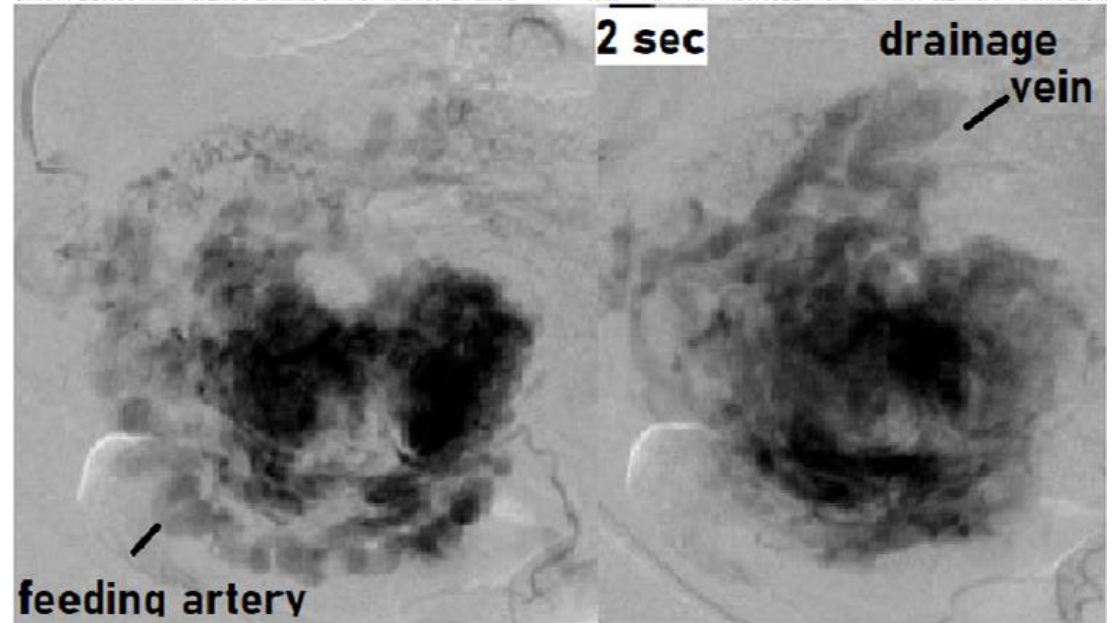
Figure 2. Findings of angiography: Abnormal engorgement in the arterial phase, with a thick venous phase visualized only 2 s later. This indicated the presence of an arteriovenous shunt. There was no pulsatile arterial perfusion in the remnant itself, where the contrast agent simply appeared to be leaking.